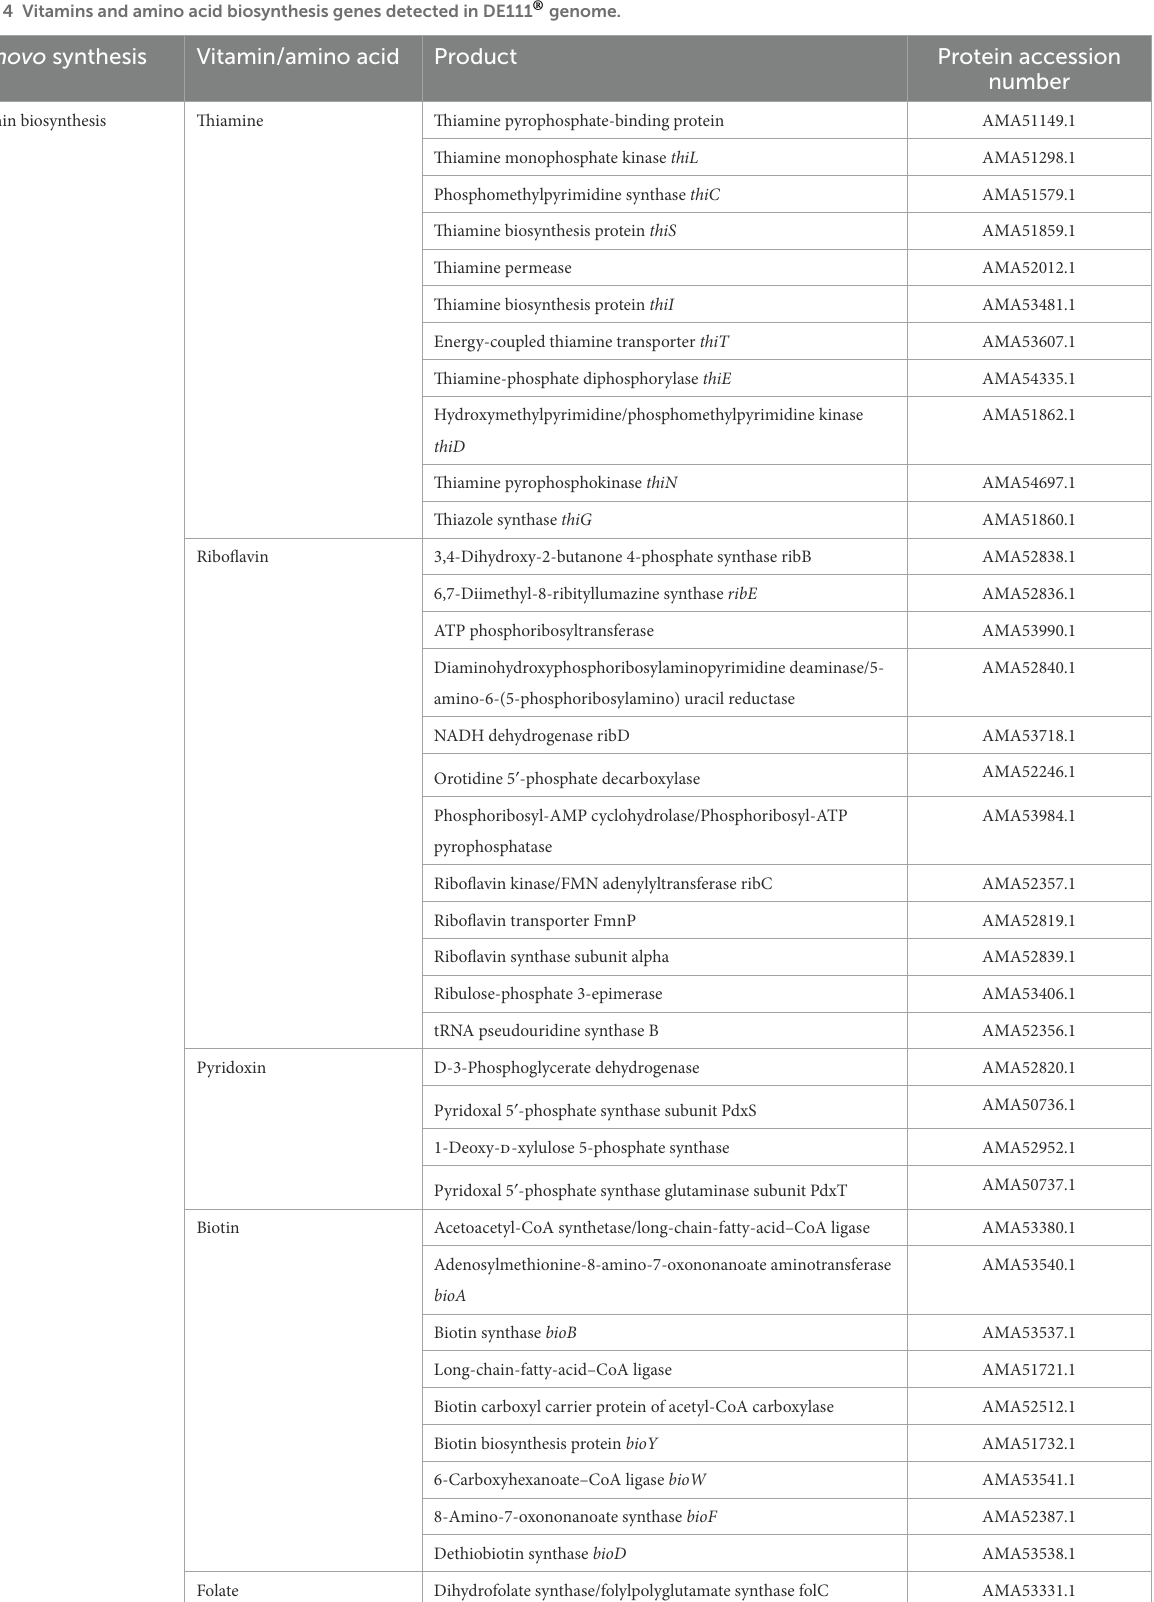
TABLE 4 Vitamins and amino acid biosynthesis genes detected in DE111 ®